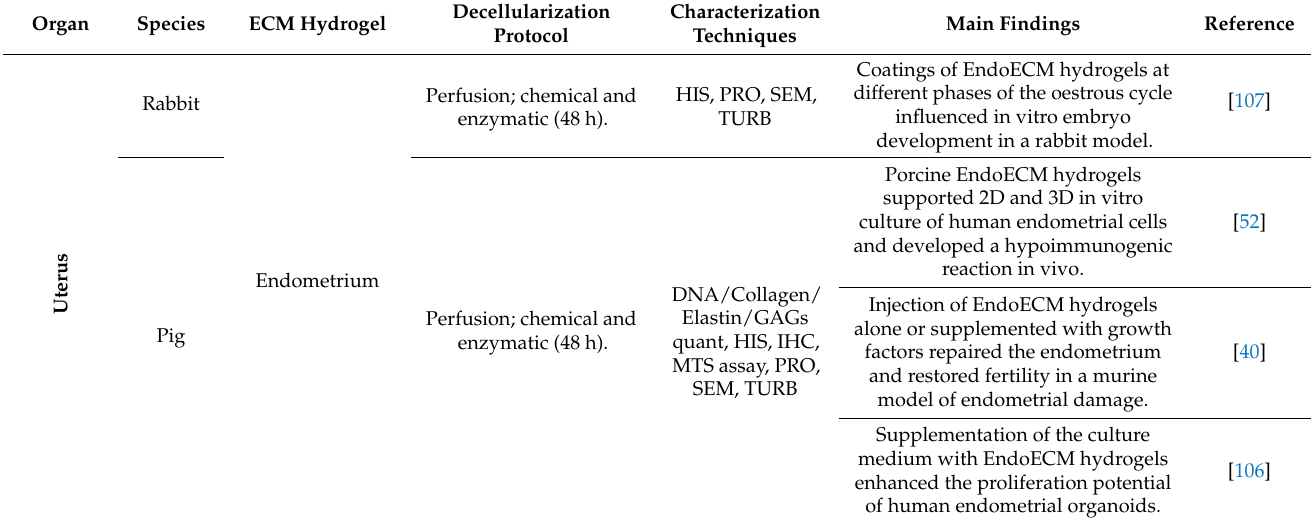
Table 1. Obtaining ECM hydrogels from the female reproductive tract. The tissue of origin, decellu- larization protocol, characterization techniques, and main findings of the studies are